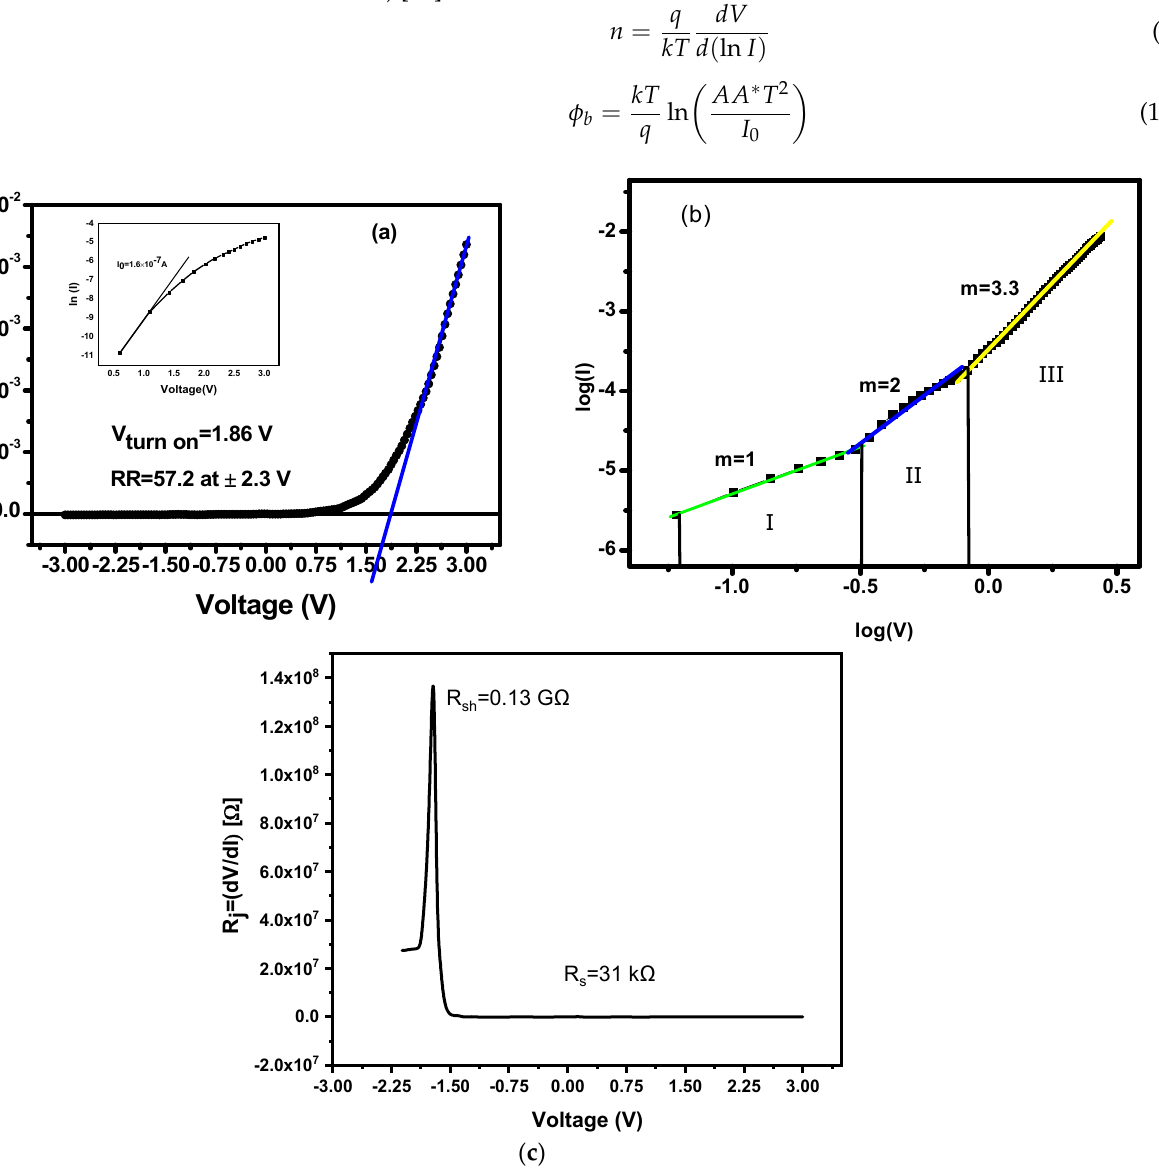
Figure 4. ( a ) I-V graph (in dark), ( inset ) semi-log I-V graph; ( b ) log I-log V curve; and ( c ) series and Figure 4. ( a ) I – V graph (in dark), ( inset ) semi-log I-V graph; ( b ) log I -log V curve; and ( c ) series shunt resistance graph of ITO/PEDOT:PSS/N749-BD/Ag heterojunction.